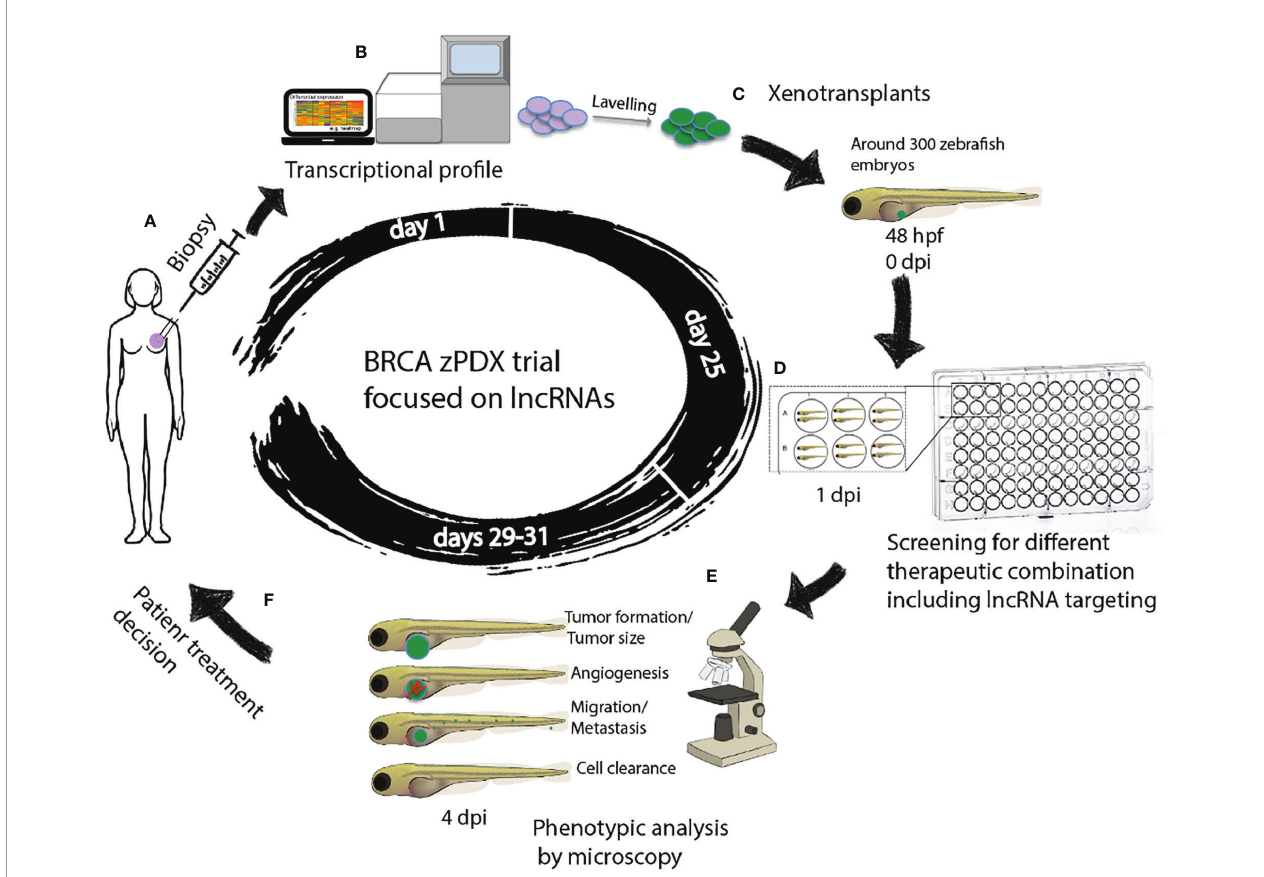
FIGURE 2 | Work fl ow of zAVATARS in the context of personalized medicine. (A – C) Experimental setup for generating zebra fi sh xenotransplant models. Cells derived from itumor biopsy are analyzed by RNAseq, subsequently labeled and microinjected in the 2dpf larvae. (D) One day after injection, larvae are screened for successful injection and distributed in groups for testing chemo-, and/or biological therapies. (E) Three days after treatment, larvae are processed for in vivo microscopy for analysis of proliferation, cell death, angiogenesis, and metastatic potential. (F) Treatment decision of breast cancer patients based on response of zebra fi sh cancer hallmarks in drug screening. hpf: hours post fertilization. dpi: days post injection. BRCA zPDX trials: Trial of patient-derived xenotransplants in zebra fi sh for the study of breast